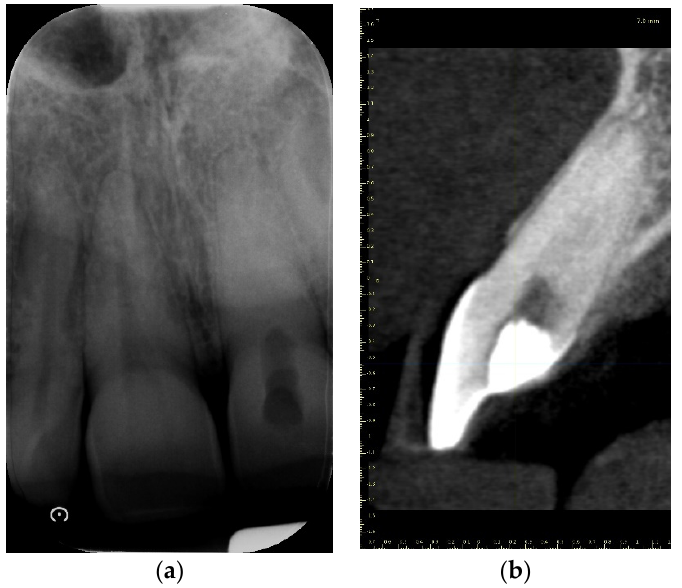
Figure 16. The failed wide access in the coronal part and root canal obliteration on ( a ) X-ray and ( b ) CBCT images.